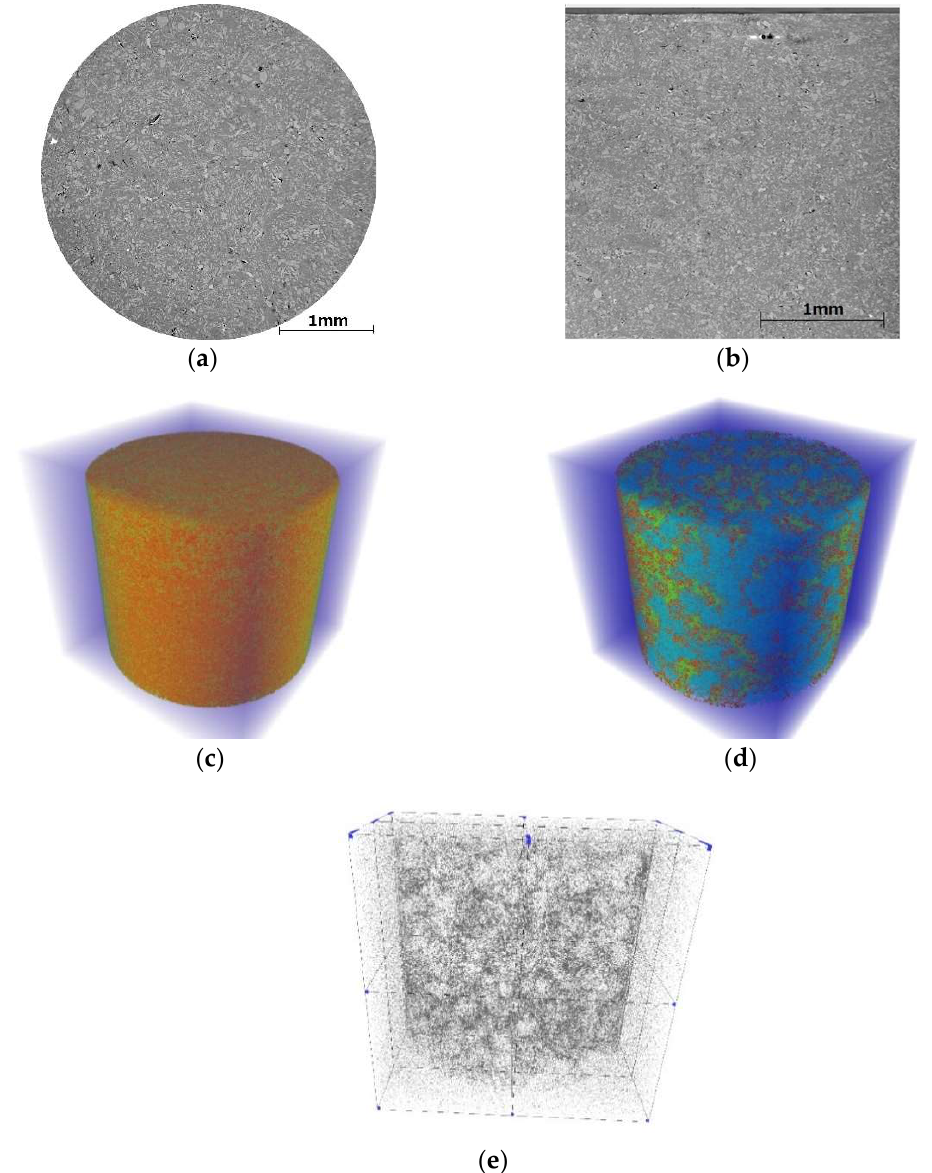
Figure 2. ( a ) The horizontal cross-sectional image of formulation A2 analyzed by microtomography. ( b ) The vertical cross-sectional image of formulation A2 analyzed by microtomography. ( c ) The results of the volume rendering from microtomographic reconstruction for formulation A2, a diameter of 2 mm (red voxel color corresponds to mefenamic acid), and ( d ) algorithmically created component arrangement, a diameter of 2 mm (blue voxels correspond to virtual mefenamic acid particles). ( e ) The skeletonized drawing of the particle distribution (only drug component) is shown after 10 s of simulated dissolution.